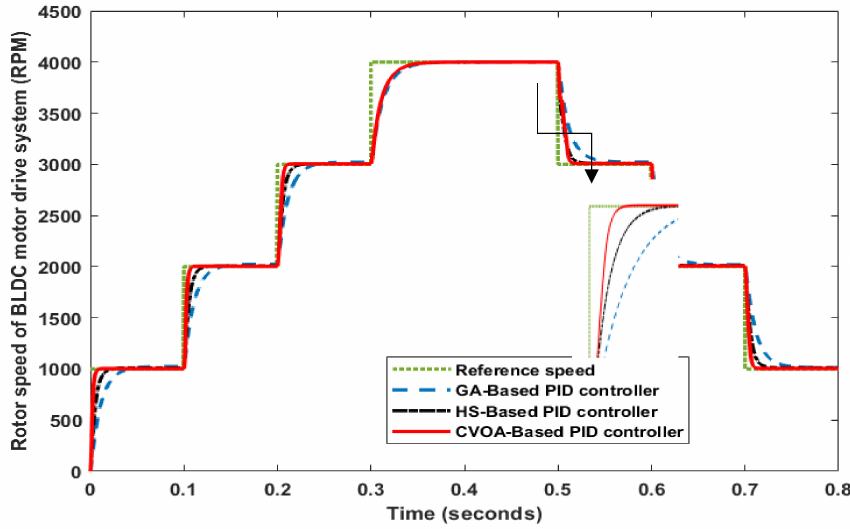
Figure 12. The rotor speed of the BLDC motor at several operating points of the reference speed test.